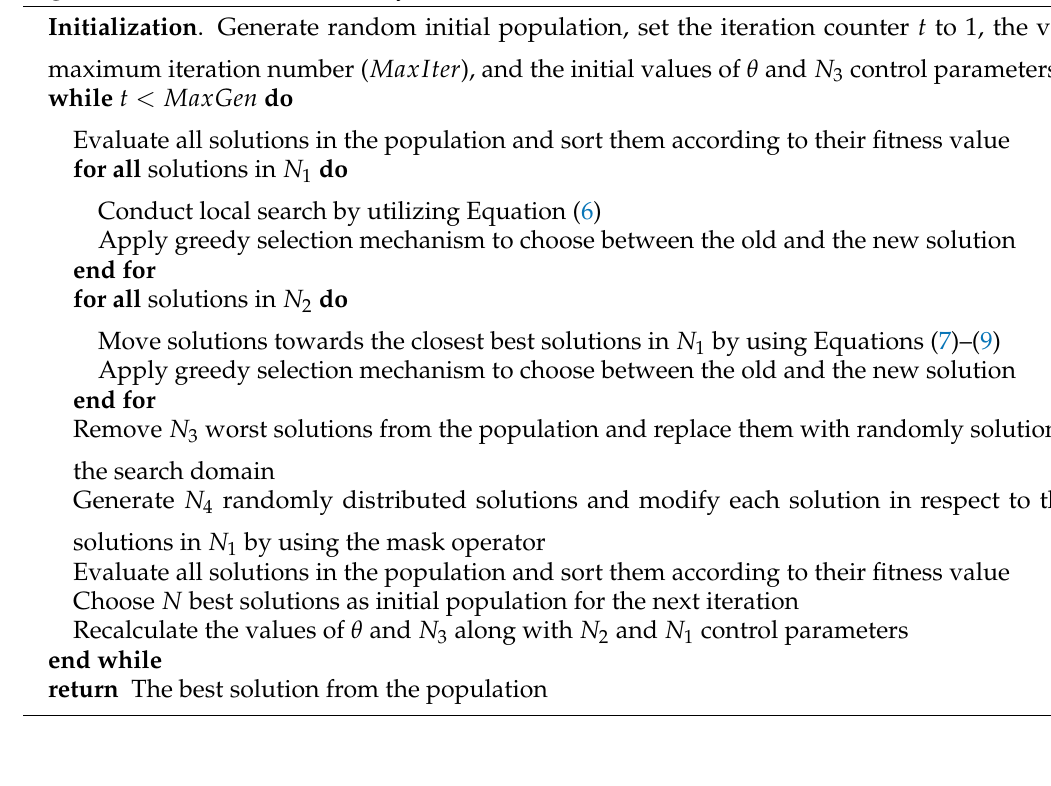
Algorithm 1 Pseudo code of the dynsTGA